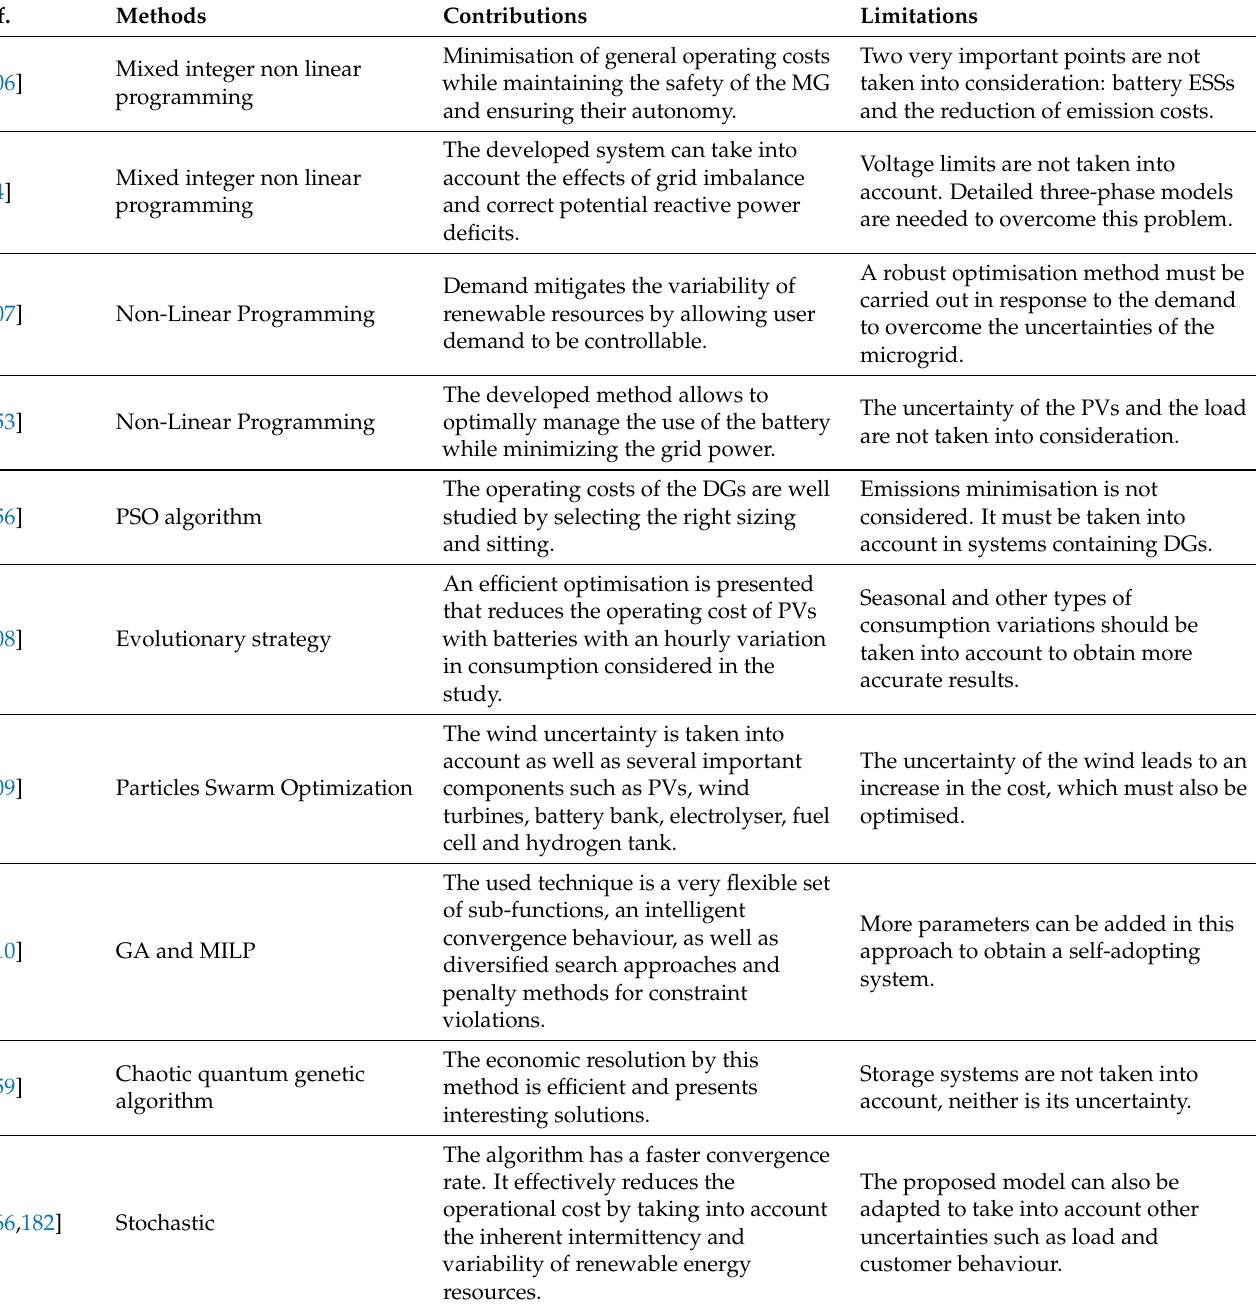
Table 4. Major papers dealing with energy management for MGs with focus on optimization approaches.